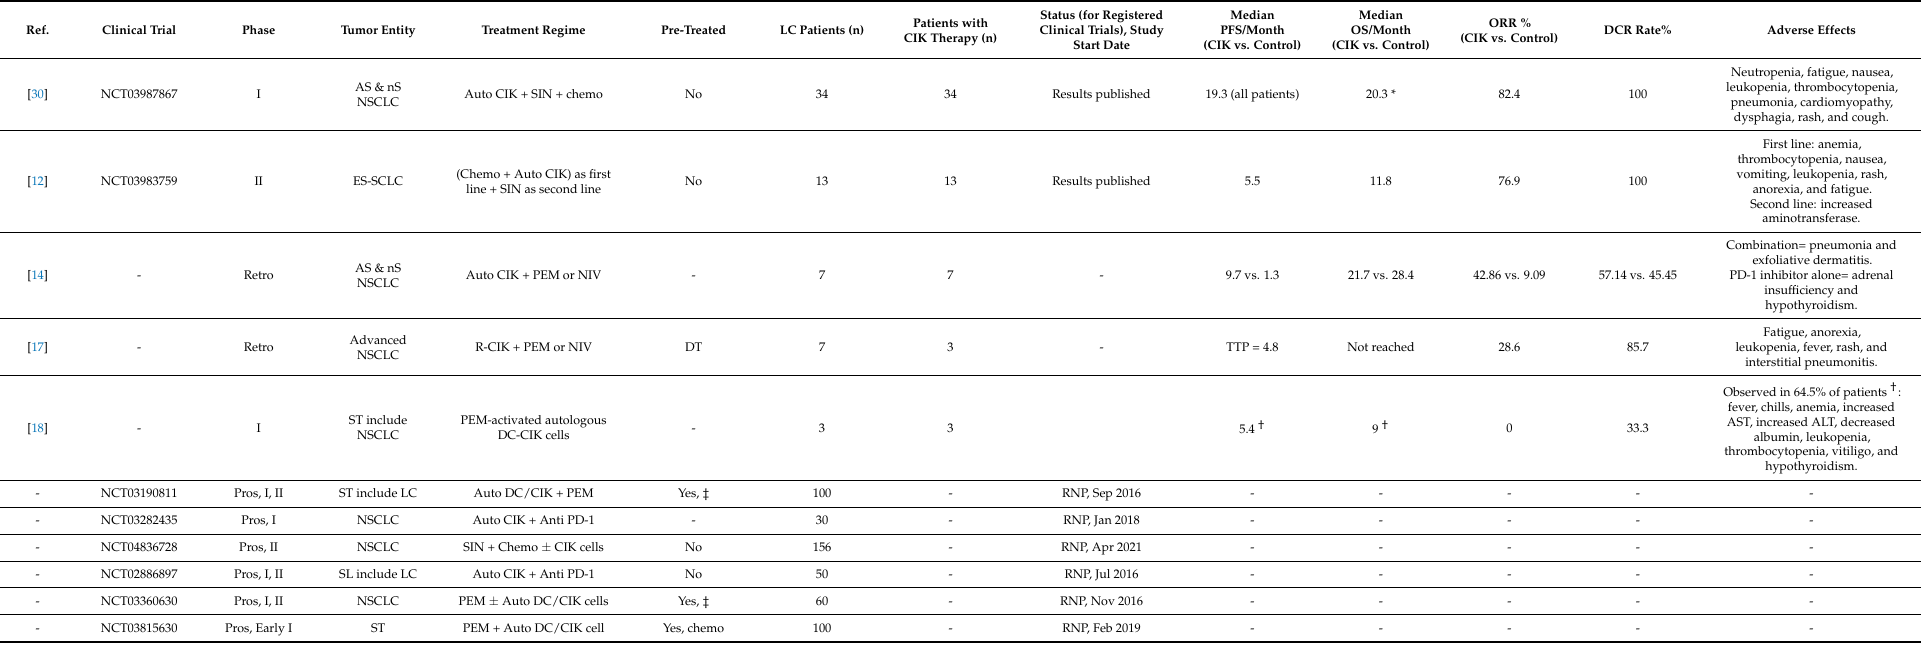
Table 1. Clinical studies regarding the combination of CIK cells and immune checkpoint